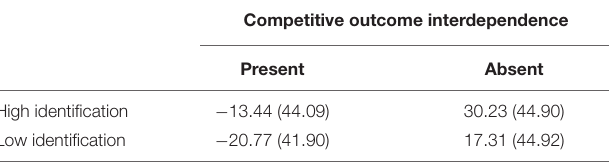
TABLE 3 | Mean difference scores according to competitive outcome interdependence and group